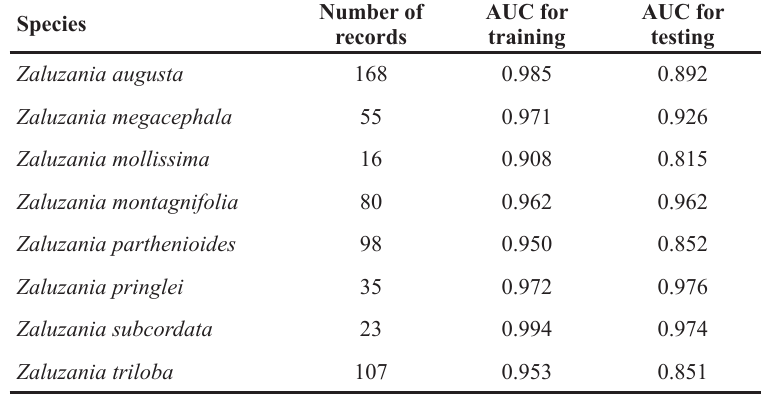
Table 2 – Species of Zaluzania analysed and number of records used to generate their potential distribution models. The area under the curve (AUC) values obtained both for training and for testing of the models are